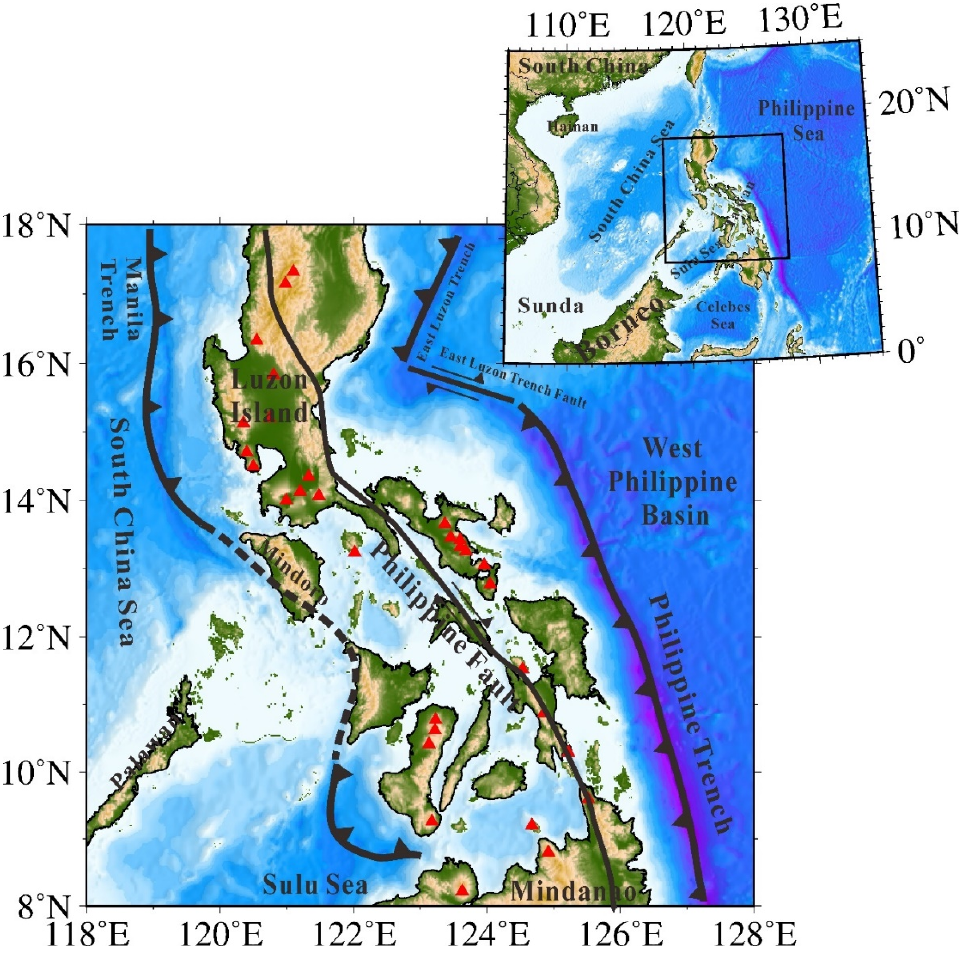
Figure 1. Tectonic framework of the central Philippine and surrounding regions. The topography data are provided by GSHHG. The saw-toothed lines indicate the trench axes. The dashed lines indicate the collision zone. The solid lines indicate active faults. The red triangles indicate the volcanoes, which are obtained from NCEI Volcano Location Database, NOAA National Centers for Environmental Information.